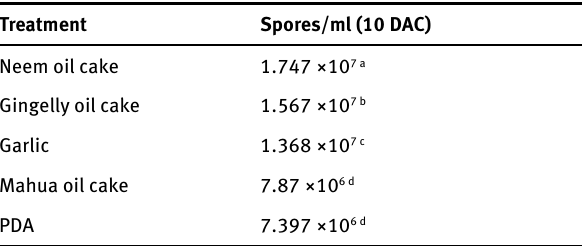
Table 3: Effect of 10% aqueous extract of oil cakes and garlic on growth and sporulation of T.